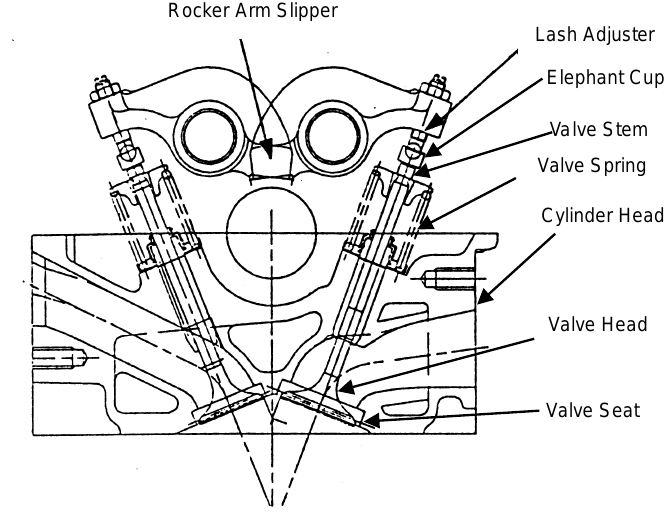
Fig. 5. Valve train system and cylinder head of the 2.0 litre, in-line 4 cylinder engine used in this test.